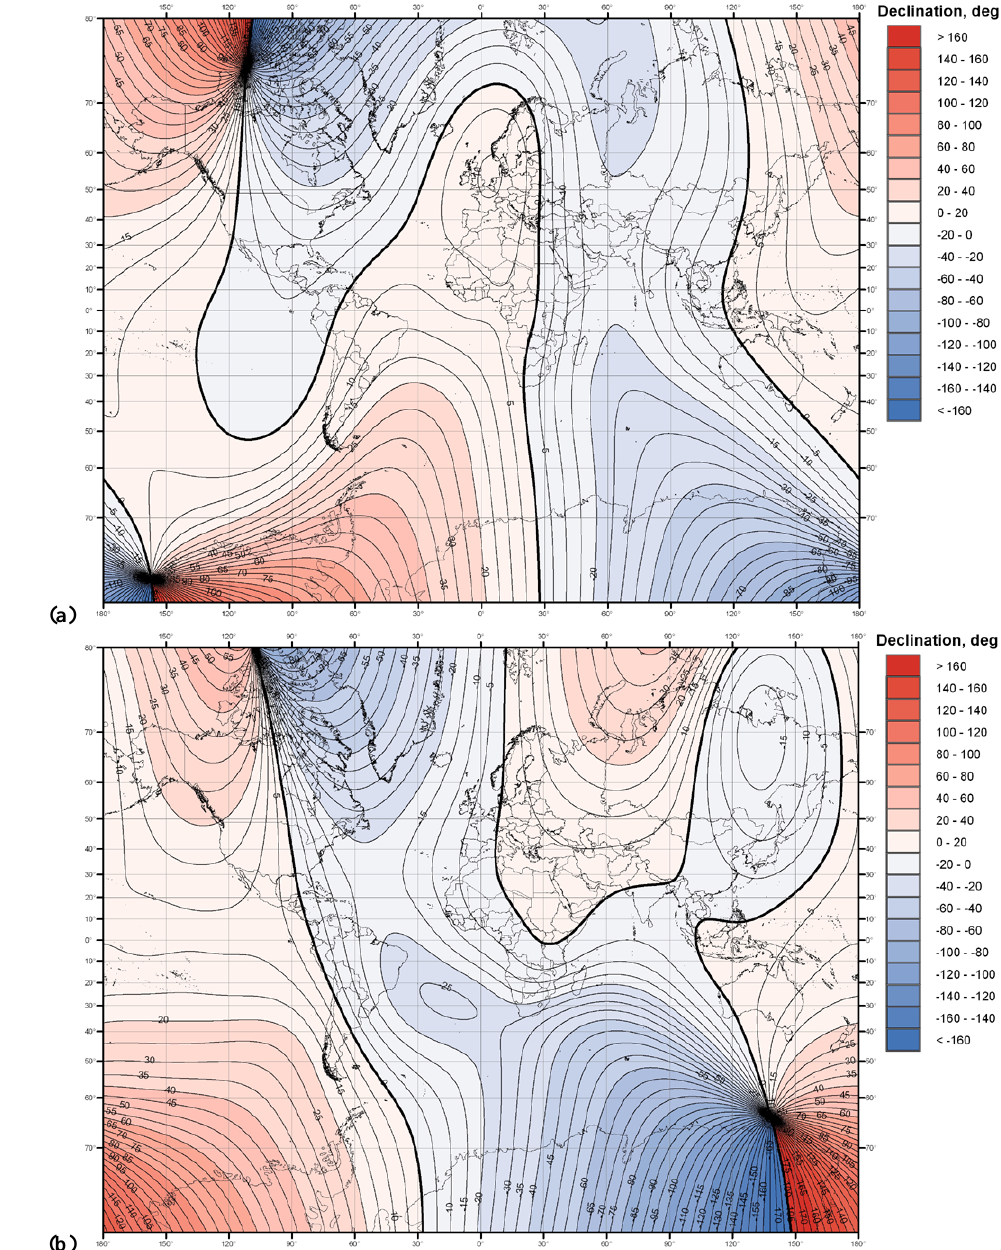
Figure 2. Observed westward drift of isogons comparing maps for 1600 (a) and 2000 (b) . Agonic lines are given in